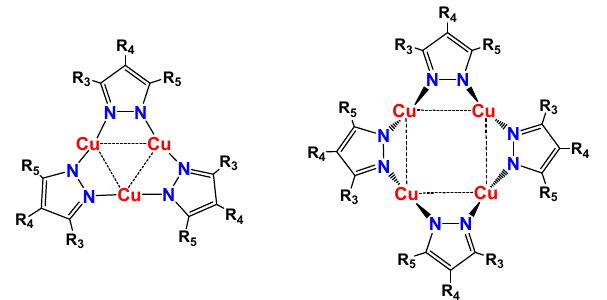
Figure 1. Tri- and tetranuclear pyrazolato copper(I) complexes showing intramolecular Cu ··· Cu interactions.